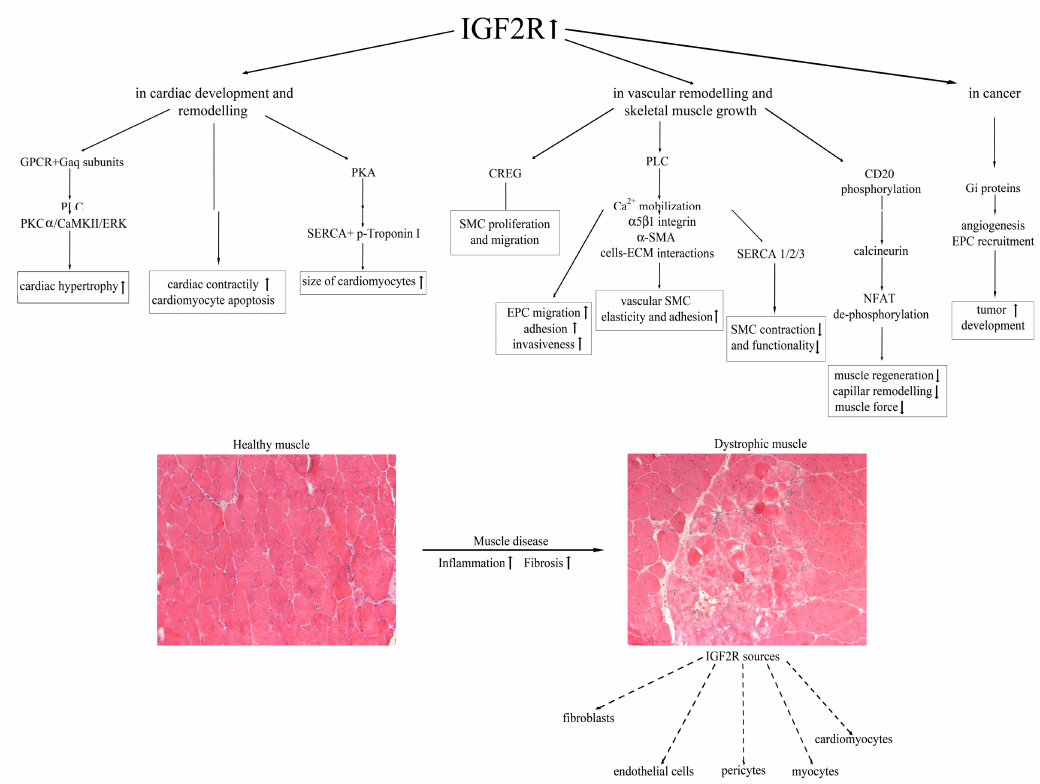
Figure 1. A schematic model of the IGF2R-dependent mechanisms leading to cardiac and skeletal muscle impairment, and cell sources of IGF2R expression in dystrophic